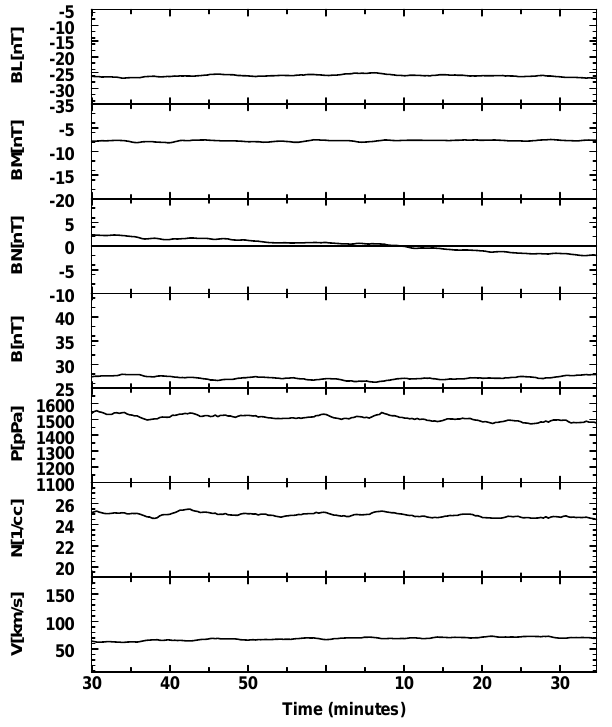
Fig. 7. Same as Fig. 5, except that the traces are taken in the summer hemisphere at 0 ◦ GSE latitude. There are no indications of